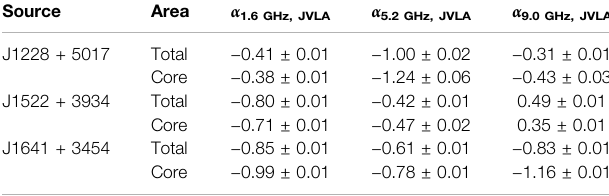
TABLE 3 | Weighted total and core spectral indices measured from the α maps.